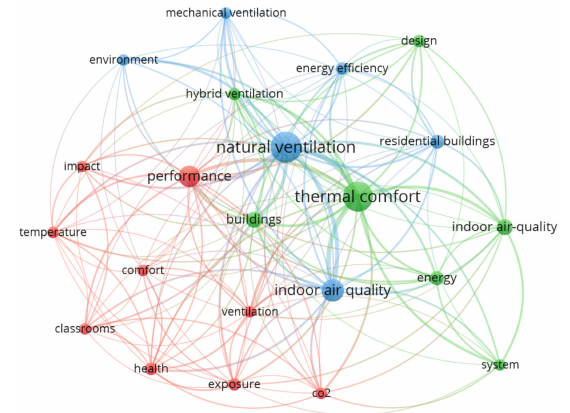
Figure 4. Co-occurrence keywords analysis of the articles included performed with VOSviewer 1.6.18 , considering the keywords with a minimum number of occurrence equal to